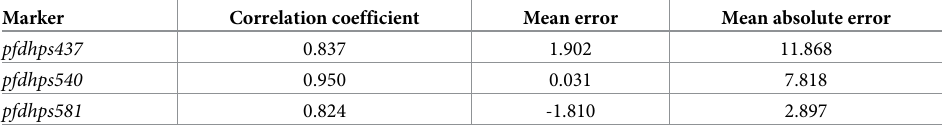
Table 3. Correlation coefficient, mean error and mean absolute error by molecular